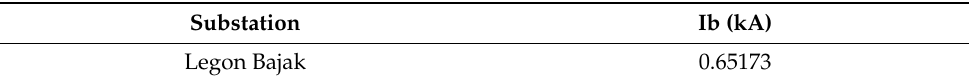
Table 5. PV system short circuit analysis.